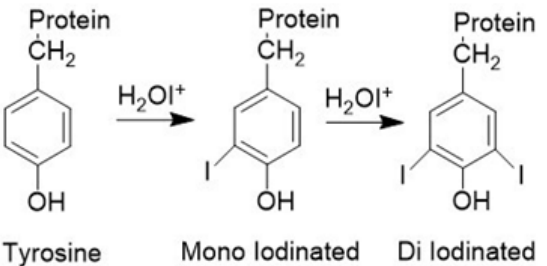
Figure 1. Radioiodine labeling scheme for tyrosine residue in peptides and proteins.